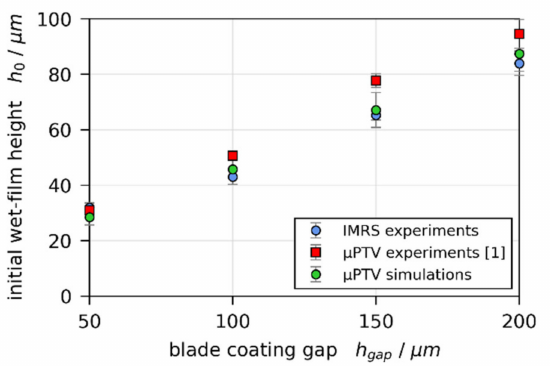
Figure 7. Comparison of initial wet-film thickness h 0 extrapolated to t = 0 s from experimental data of 3D- µ PTV (red markers) and IMRS (blue markers), as well as from 1D simulations, matched to the dry-film thickness of 3D- µ PTV experiments (green